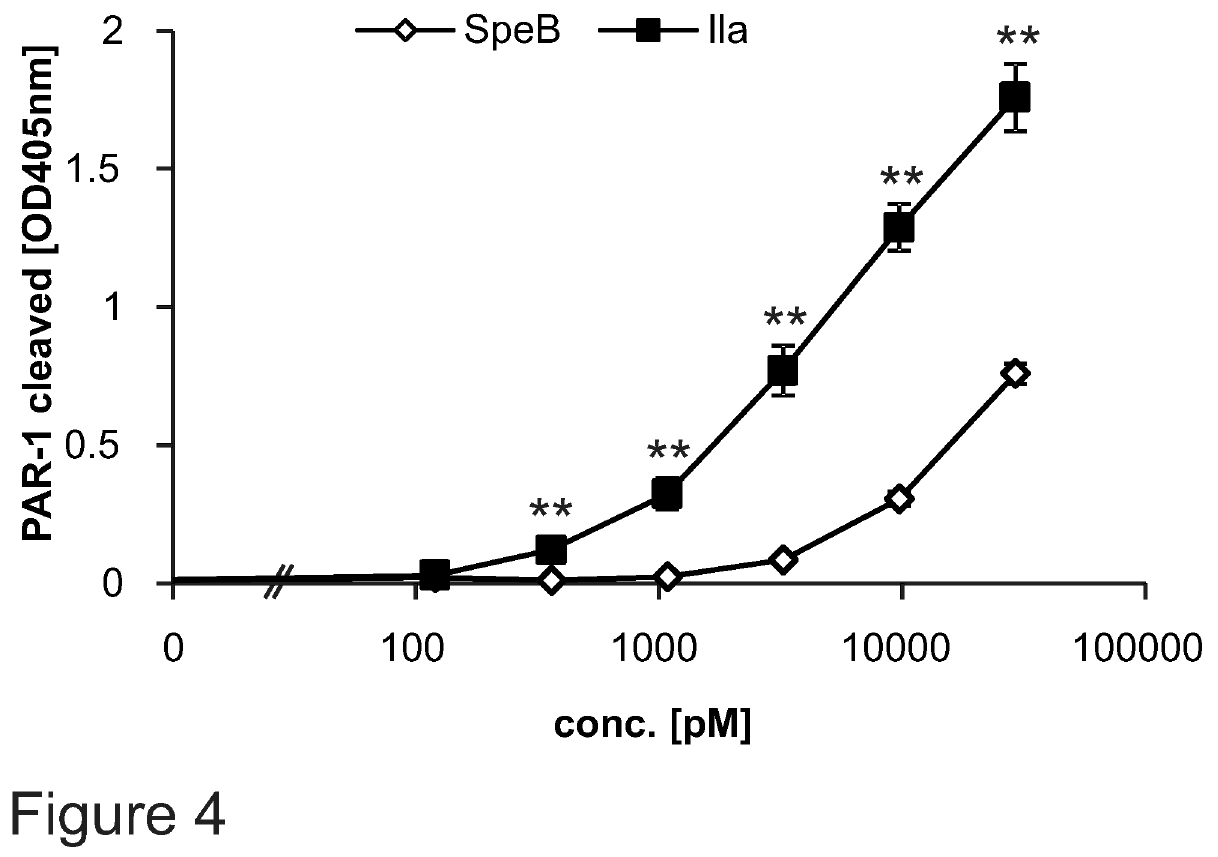
Figure 4. AP-PAR-1 cleavage efficiency by SpeB and thrombin. A large concentration range (starting at 10pM up to 29nM) of commercial SpeB and thrombin (IIa) was analysed for AP-PAR-1 cleavage efficiency. Experiments were repeated at least 3 times with N=9 per point, data presented as mean+/- SEM, * P <0.05, ** P <0.01. doi: